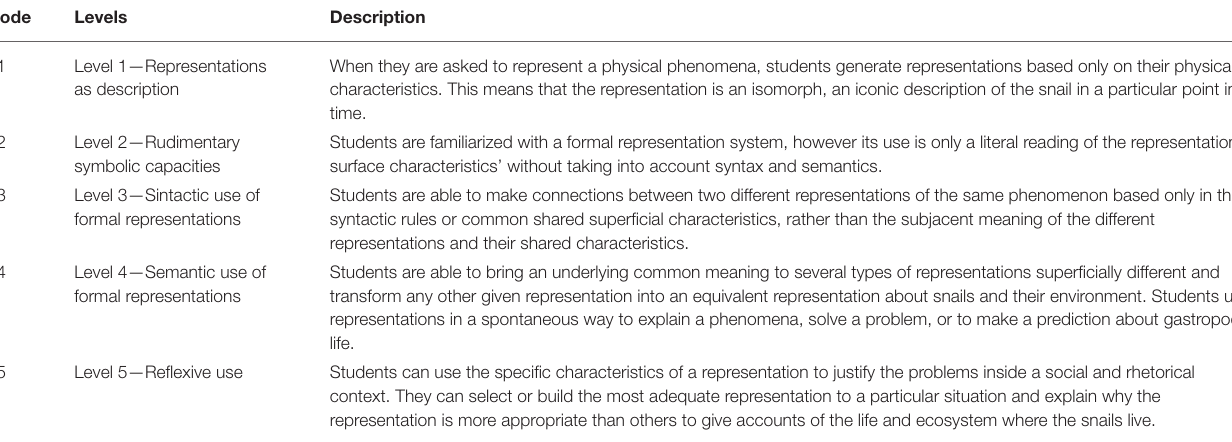
TABLE 1 | Instrument to analyze students’ answers to the proposed activities of the TLS.